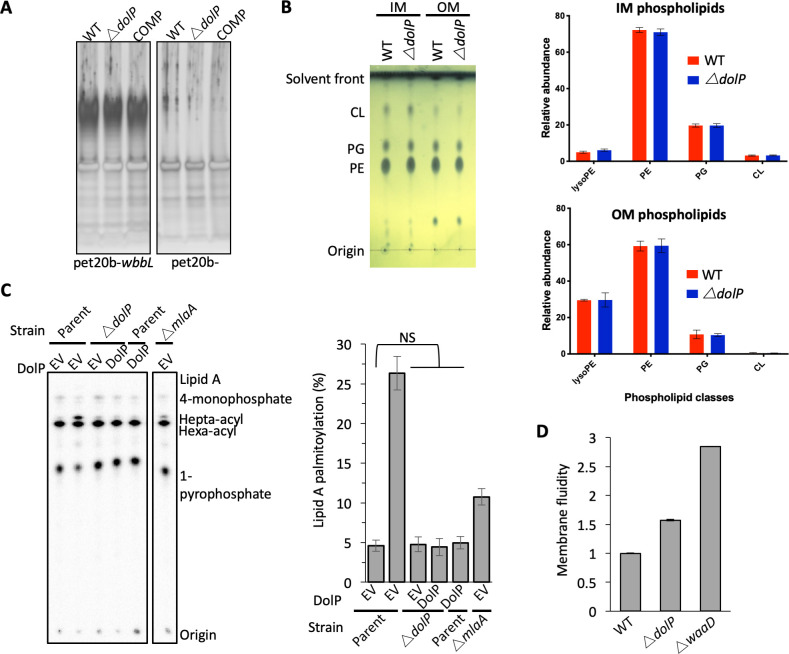
Loss of DolP affects membrane fluidity, but does not affect membrane lipid profiles.(A) SDS-PAGE gel showing separation of LPS preparations from E. coli BW25113 and E. coli BW25113 harbouring pET20b-wbbL which restores O-antigen expression on the bacterial cell surface. (B) Analysis of phospholipid profiles from purified ∆dolP cell envelopes. Phospholipids were extracted by the Bligh-Dyer method from E. coli IM or OM samples purified by sucrose density gradient centrifugation. Phospholipids were visualised by staining with phosphomolybdic acid and charring after being separated by thin-layer chromatography with the following mobile phase: Chloroform:methanol:acetic acid (65:25:10). Phospholipid profiles were also analysed by LC/MS-MS following separation on the Luna C8(2) column under a THF/MeOH/H2O gradient. Phospholipid compositions are shown as sum for each of the four major classes observed: lyso-phophatidylethanolamines (LysoPE), phosphatidylethanolamines (PE), phosphatidylglycerols (PG) and cardiolipins (CL). Each data set is from three biological replicates generated from three separately purified membranes. Error bars represent ±S.D. (C) PagP-mediated Lipid A palmitoylation assay. PagP transfers an acyl chain from surface exposed phospholipid to hexa-acylated Lipid A to form hepta-acylated Lipid A. [32P]-labelled Lipid A was purified from cells grown to mid-exponential phase in LB broth with aeration. An equal amount of radioactive material (cpm/lane) was loaded on each spot and separated by thin-layer chromatography before quantification. As a positive control, cells were exposed to 25 mM EDTA for 10 min prior to Lipid A extraction in order to chelate Mg2+ ions and destabilise the LPS layer, leading to high levels of Lipid A palmitoylation. Hepta-acylated and hexa-acylated lipid A was quantified and hepta-acylated Lipid A represented as a percentage of total. Triplicate experiments were utilised to calculate averages and standard deviations with students t-tests used to assess significance. Student’s t-tests: NS* p>0.1 compared with Parent EV. (D) E. coli BW25113 cells were grown overnight in LB (~16 hr) before being harvested by centrifugation and washed three times in PBS. Membrane fluidity was measured for each strain in triplicate and error bars represent standard deviation. Membrane fluidity is expressed as relative to E. coli BW25113 parent cells (WT).Figure 3—figure supplement 2—source data 1.LPS production in a dolP negative background.Figure 3—figure supplement 2—source data 2.Phospholipid content of membranes isolated from a dolP mutant.Figure 3—figure supplement 2—source data 3.Comparison of hepta- and hexa-acylated LPS levels.Figure 3—figure supplement 2—source data 4.Raw data for membrane fluidity assay.